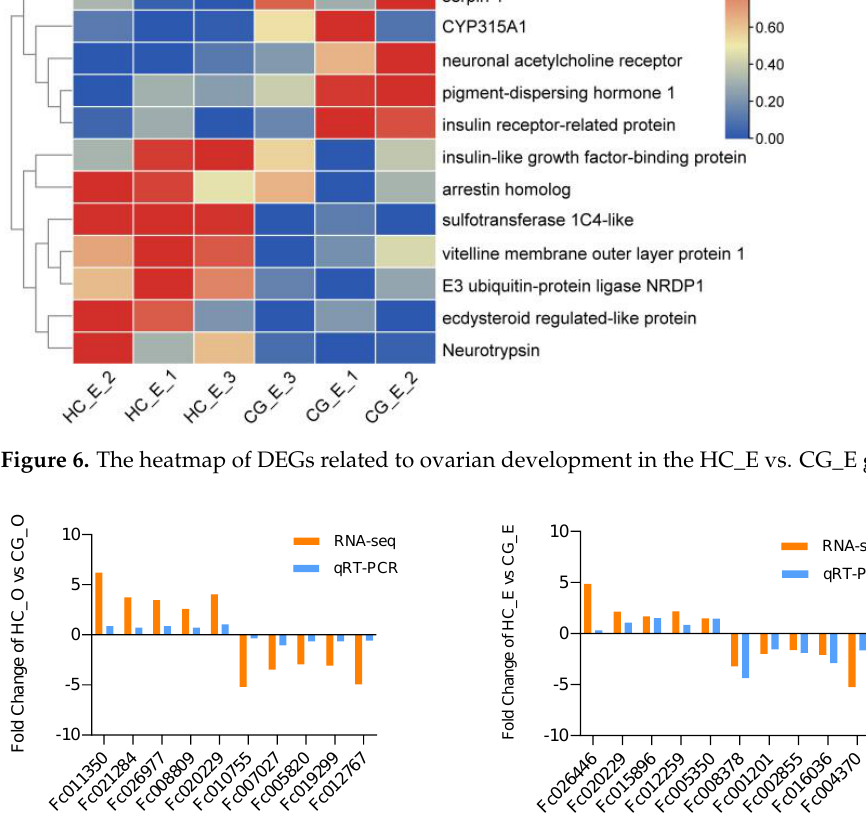
Figure 7. The results were verified by qRT − PCR. ( a ) Relative fold change of DEGs between qRT − PCR and RNA − seq results in HC_O vs. CG_O group. ( b ) Relative fold change of DEGs between qRT-PCR and RNA − seq results in HC_E vs. CG_E group. Relative expression levels from the RNA − seq results were calculated as log2FC values. Fc011350 ecdysteroid regulated; Fc021284 legumain; Fc026977 lysosome − associated membrane glycoprotein 1; Fc008809 baculoviral IAP repeat-containing; Fc020229 N − acetylated − alpha − linked acidic dipeptidase; Fc010755 high − affinity choline transporter 1; Fc007027 Wnt 4; Fc019299 tachykinin − like peptides receptor; Fc005820 reelin 3; Fc012767 facilitated trehalose transporter; Fc026446 neuroligin 2; Fc015896 insulin receptor − related; Fc012259 serpin 1; Fc005350 UDP − glucosyltransferase 2; Fc008378 crustacyanin − C1; Fc001201 legumain; Fc002855 cathepsin L; Fc016036 multidrug resistance − associated protein; Fc004370 macrophage mannose receptor 1.